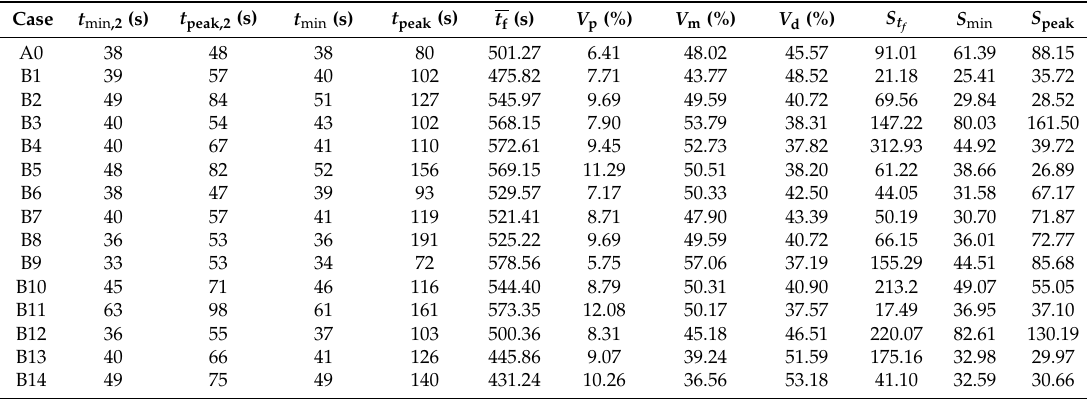
Table 9. Flow characteristic parameters in isothermal experiment Part